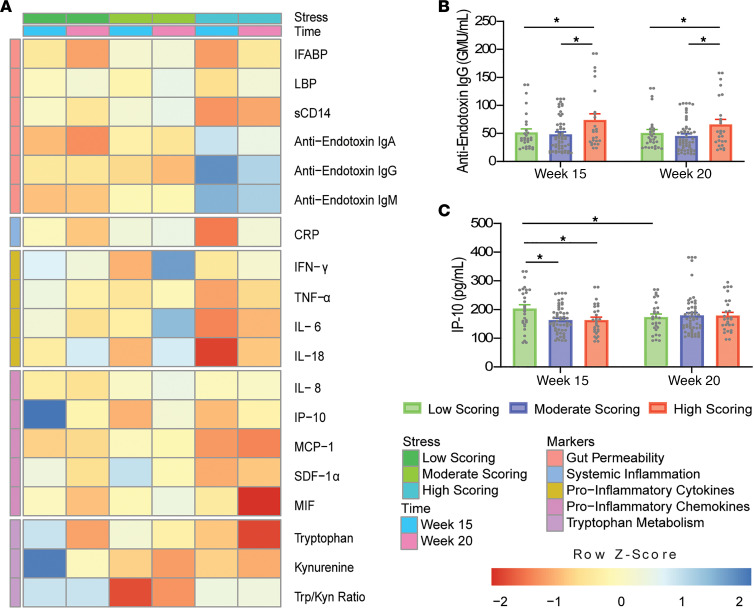
Differences in PSS-scoring groups across gestational time points in the IBS cohort (N = 29/55/21 from low/moderate/high).(A) Heatmap of normalized biomarker means across scoring groups and time points. Individual boxes are represented on a scale from red to blue. Darker red boxes represent markers whose concentrations were found to be at least 1 standard deviation lower than the mean concentration across stress group and time point. Darker blue boxes represent markers whose concentrations were found to be at least 1 standard deviation higher than the mean concentration across stress group and time point. Higher z scores are evident for IP-10 and Kyn in the low-scoring group at 15 weeks and for anti-endotoxin IgG in the high-scoring group at 15 weeks. Significant differences between PSS-scoring groups are illustrated for (B) anti-endotoxin IgG and (C) IP-10 (2-way ANOVA with Tukey’s HSD). *P < 0.05. GMU, IgG median units.